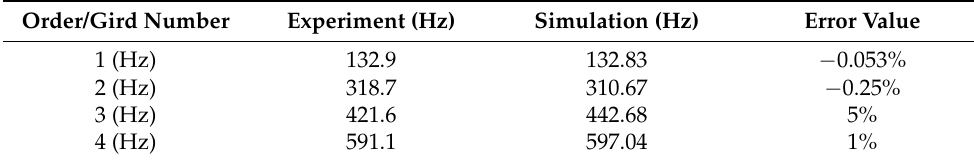
Table 7. Comparison of the first four order inherent frequencies obtained through shell simulation and